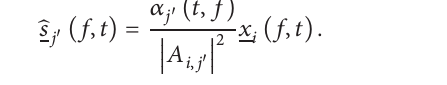
Algorithm 1: Gain estimation